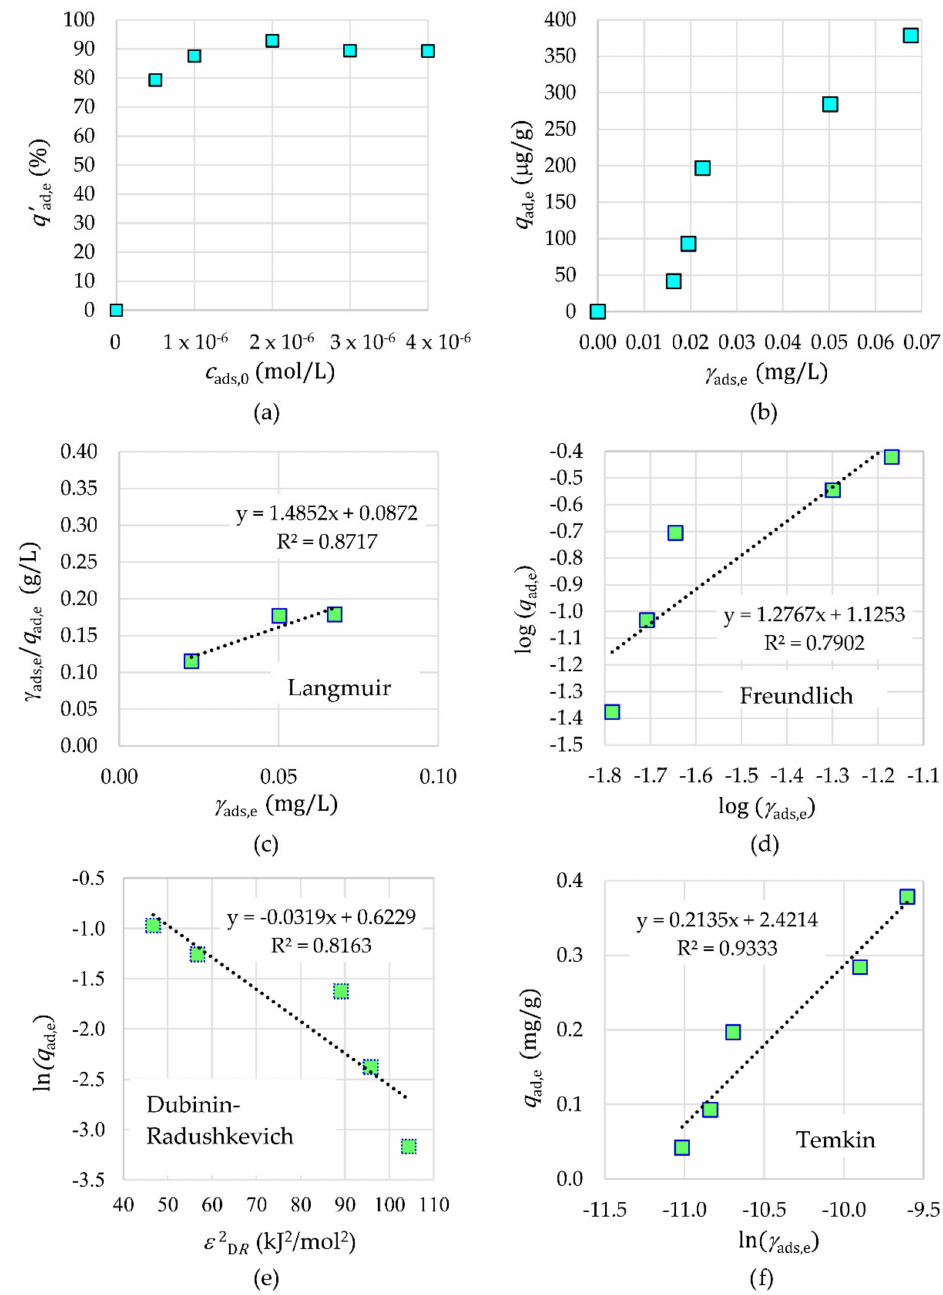
Figure 12. The influence of initial concentration ( a ) and equivalent concentration ( b ) on adsorption. Adsorption isotherms for Tb 3 + on γ -Fe 2 O 3 -NH 4 OH@SiO 2 (APTMS) NPs: Langmuir ( c ), Freundlich ( d ), Dubinin–Radushkevich ( e ), and Temkin ( f